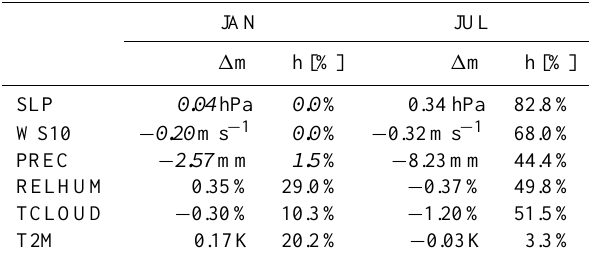
Table 3. Difference in mean (bias) between HiResAFF and RCAO (RCAX for T2M) for January (left) and July (right). Additionally shown is the amount of local tests h [%] showing significant bias with p < 0 . 05. Globally non-significant bias with p < 0 . 05 is indi- cated by